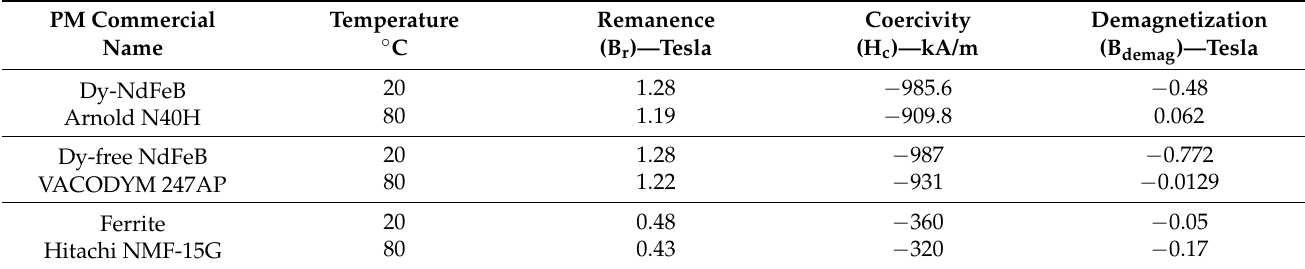
Table 3. PM properties at 20 and 80 ◦